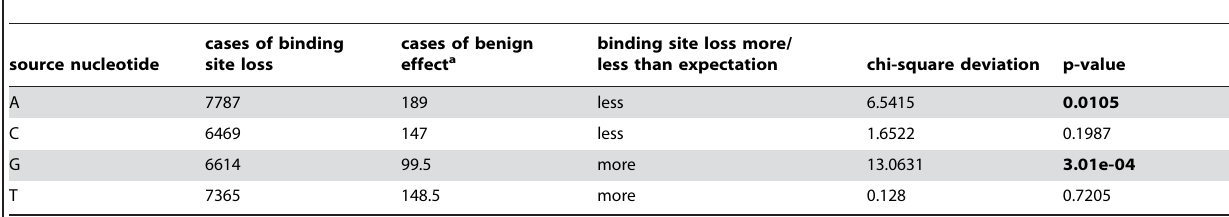
Table 3. Comparison of the distributions of substitution types among cases of binding site loss and those of benign effect, pooling together substitution types with the same source